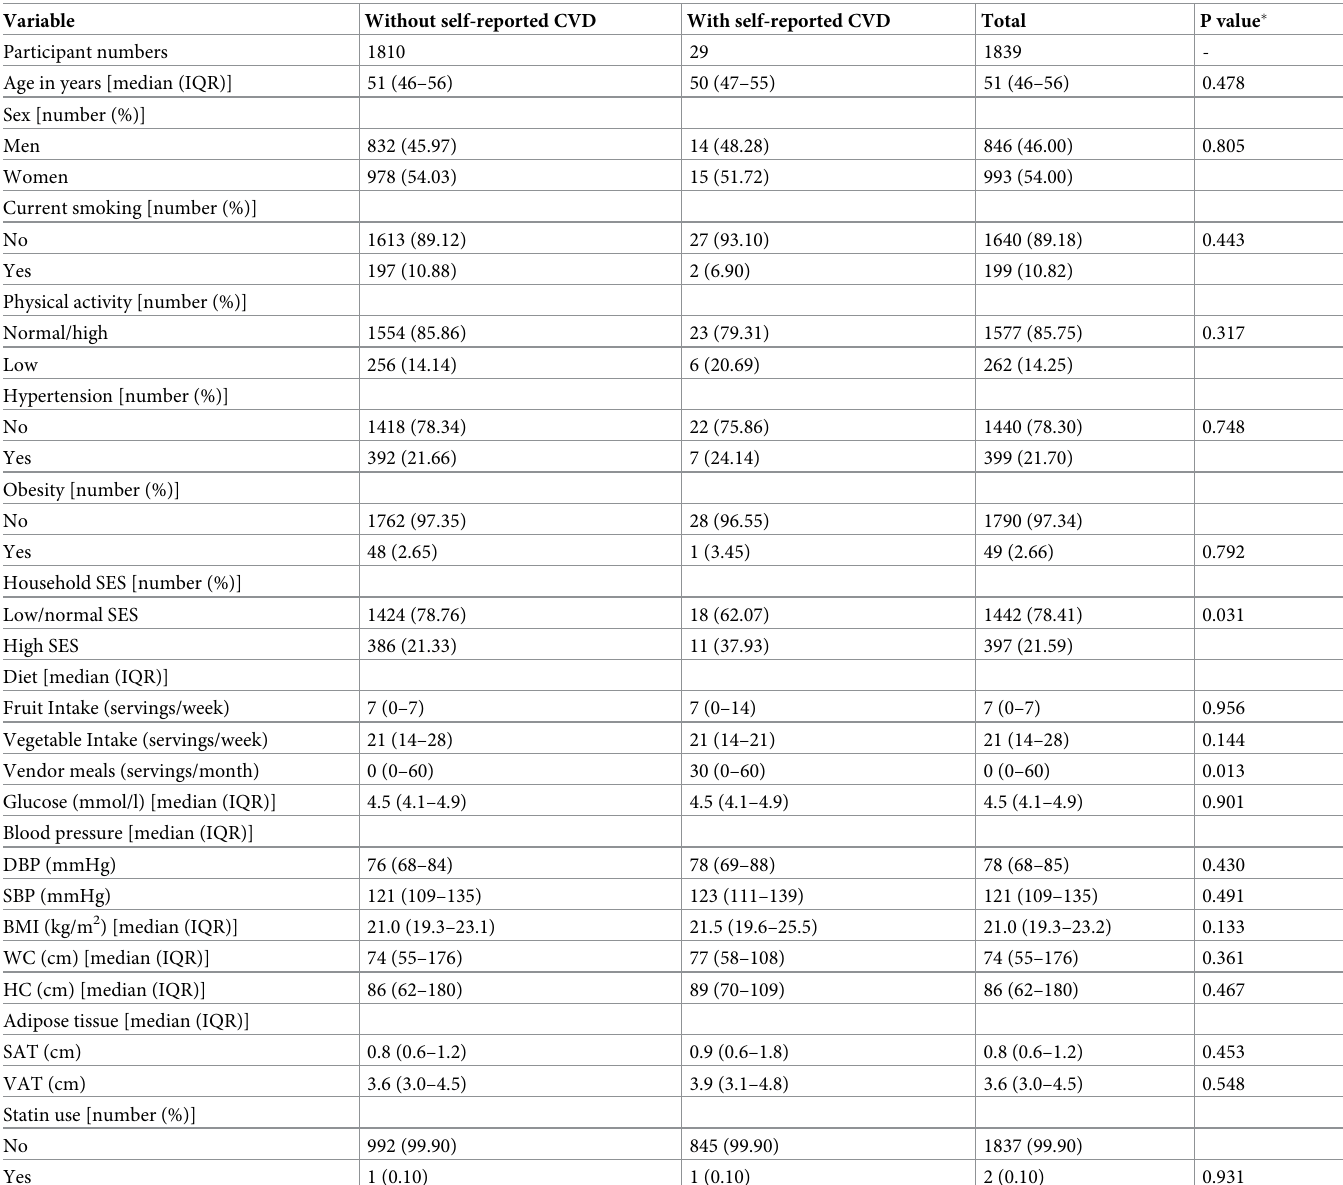
Table 1. Characteristics of the study